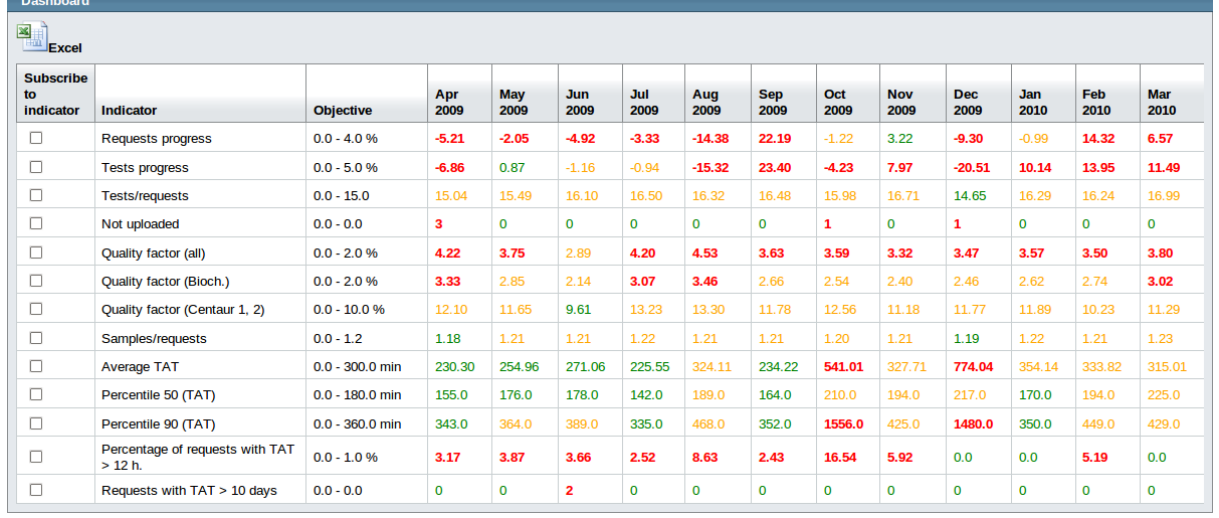
Figure 3. Dashboard